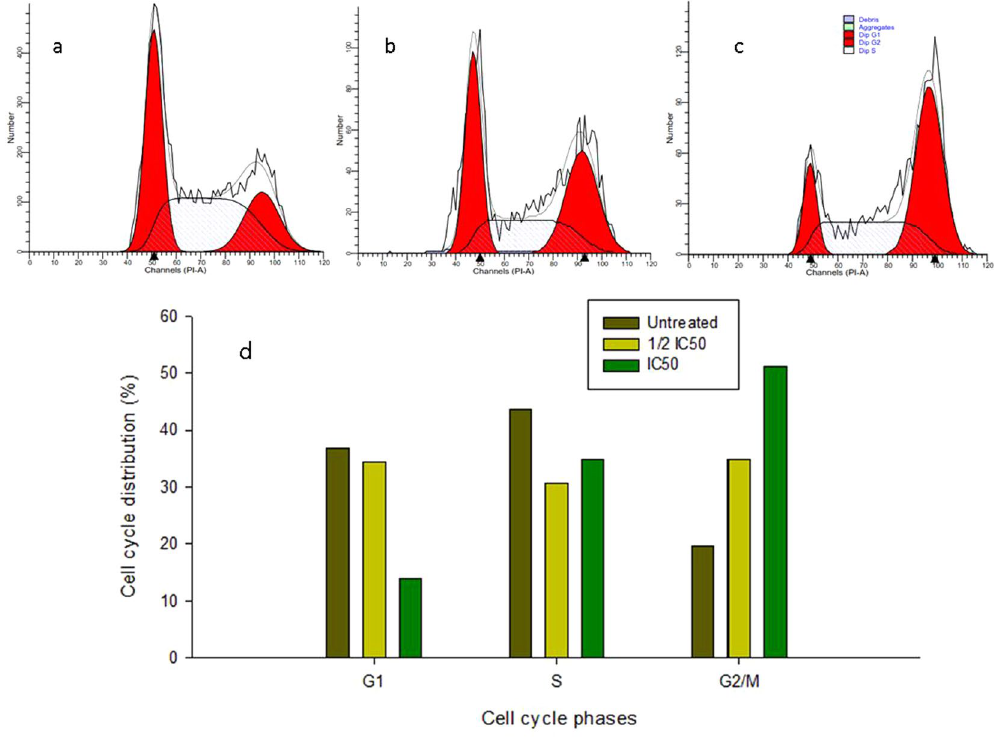
Figure 13. The cell cycle arrest caused by CPT-CEF in a concentration-dependent manner in A549 cells. ( a ) Untreated, ( b ) 1/2 IC 50 treated cells and ( c ) IC 50 treated A549 cells. ( d ) The graphical representation of the trend in cell cycle arrest of A549 cells in response to CPT-CEF